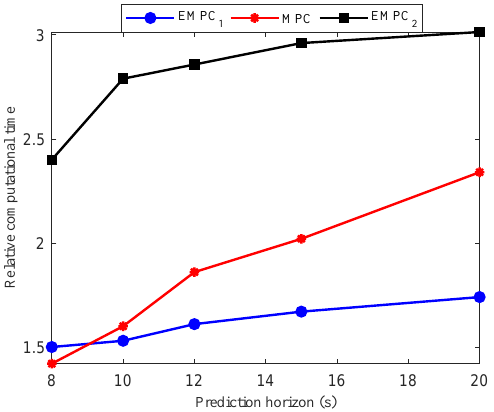
Figure 15. Computational time for different prediction